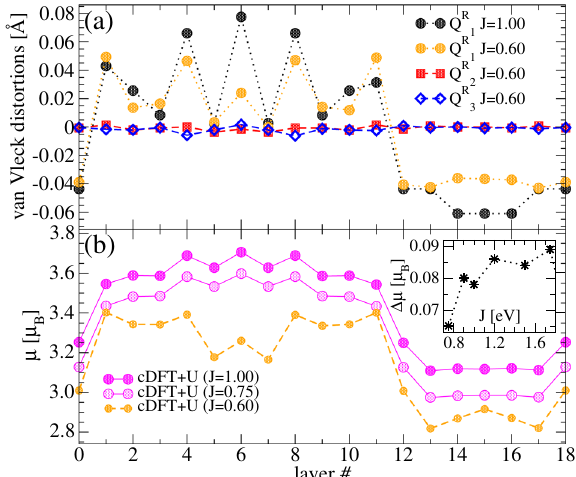
Fig. 6 Dependence of the distortions and charge/spin distribution on the correlation. a Layer-resolved van Vleck distortions and ( b ) Mn-projected Bader magnetic moments for different values of Hund ’ s exchange J (in eV). See the Methods section for details on cDFT + U ∣ J and sDFT + U ∣ J. Inset: difference Δ μ between the magnetic moments at layers #5 and #6, which provides a measure of the amplitude of the moment